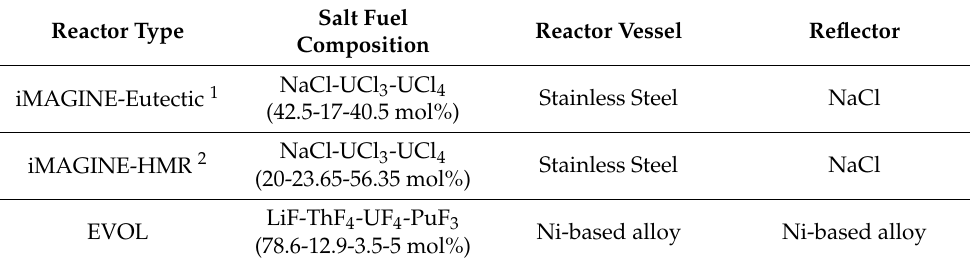
Figure 1. Configuration of simulated reactor core: ( a ) side view; ( b ) top view; ( c ) 3D wireframe view. Table 1. Salt fuel systems were considered for iMAGINE and EVOL projects.